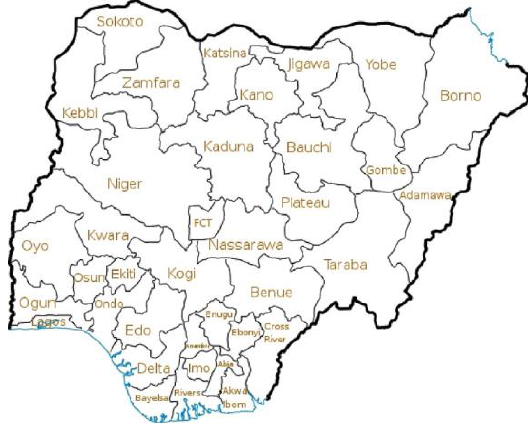
Figure 1: Map of Federal Republic of Nigeria.